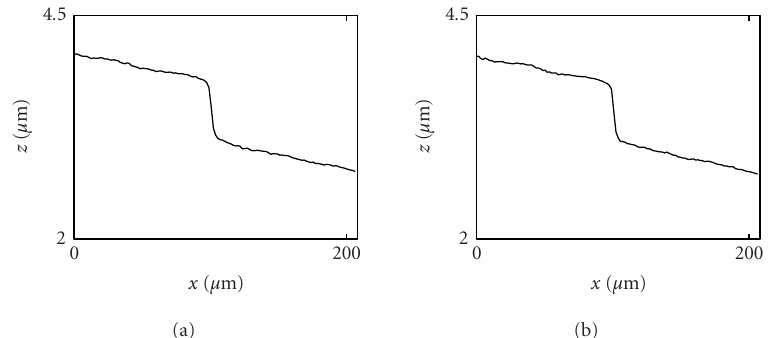
Figure 12: Surface profiles using undersampled data. (a) ( k , m ) = (0,4), T e = 100 nm and (b) ( k , m ) = (0,2), T e = 120 nm.